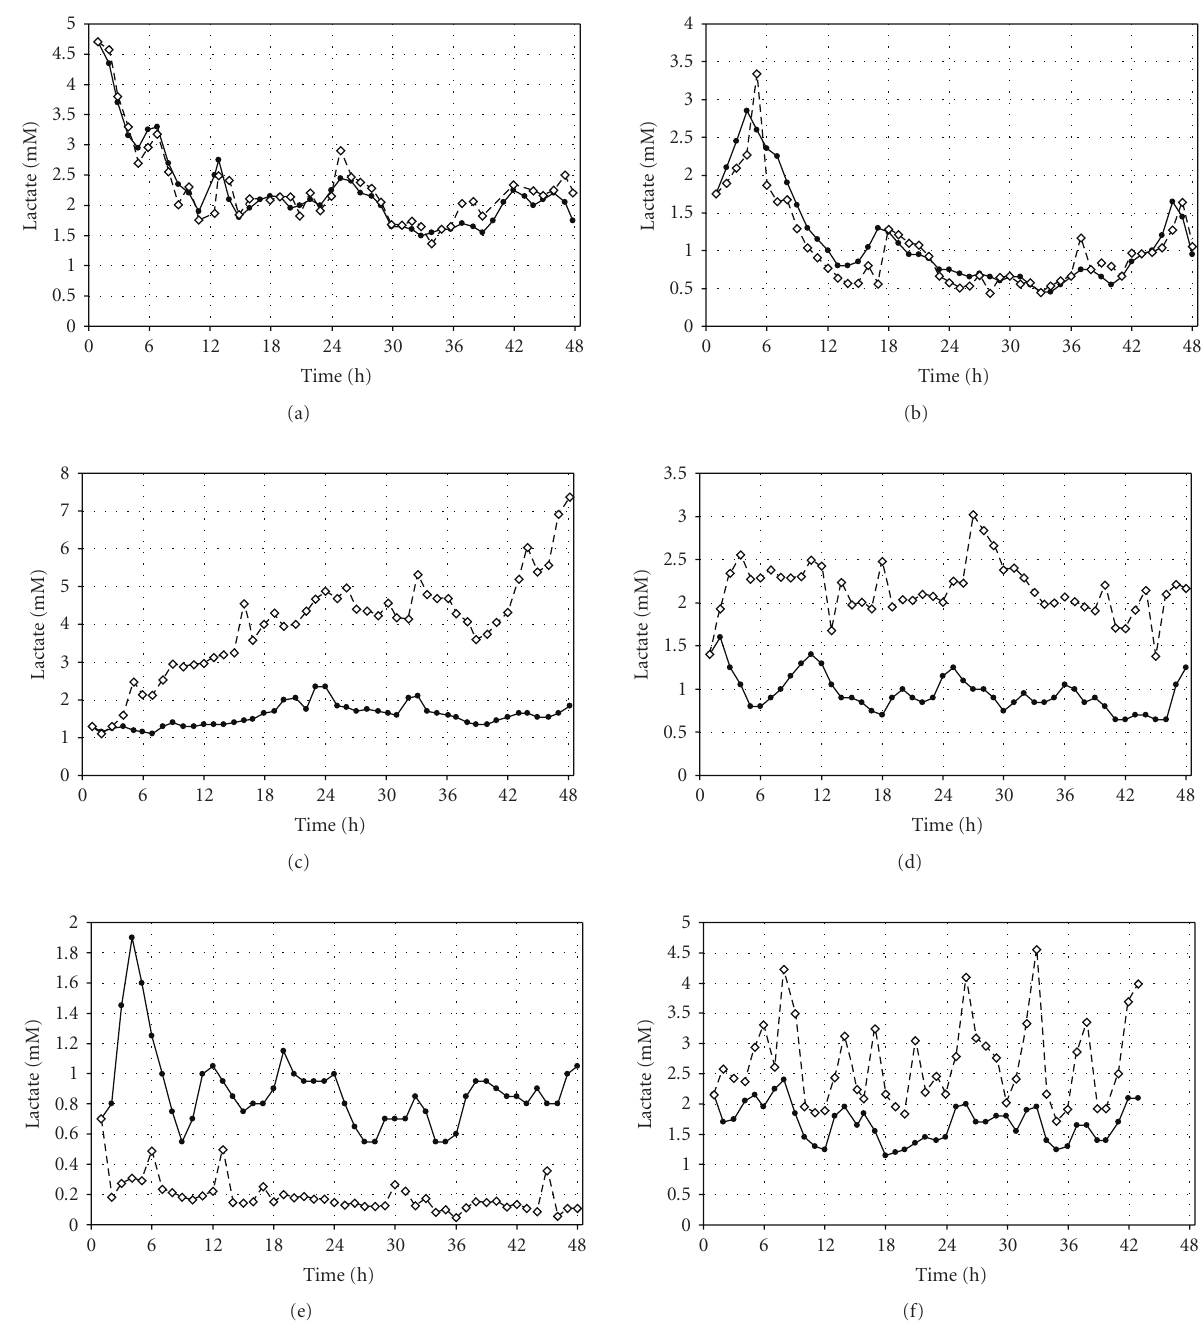
Figure 2: Time profiles for individual patients. Arterial lactate (closed symbols) versus subcutaneous adipose tissue lactate (open symbols) concentrations. Panels indicate examples with di ff erent levels of interrelation between arterial and subcutaneous adipose tissue lactate